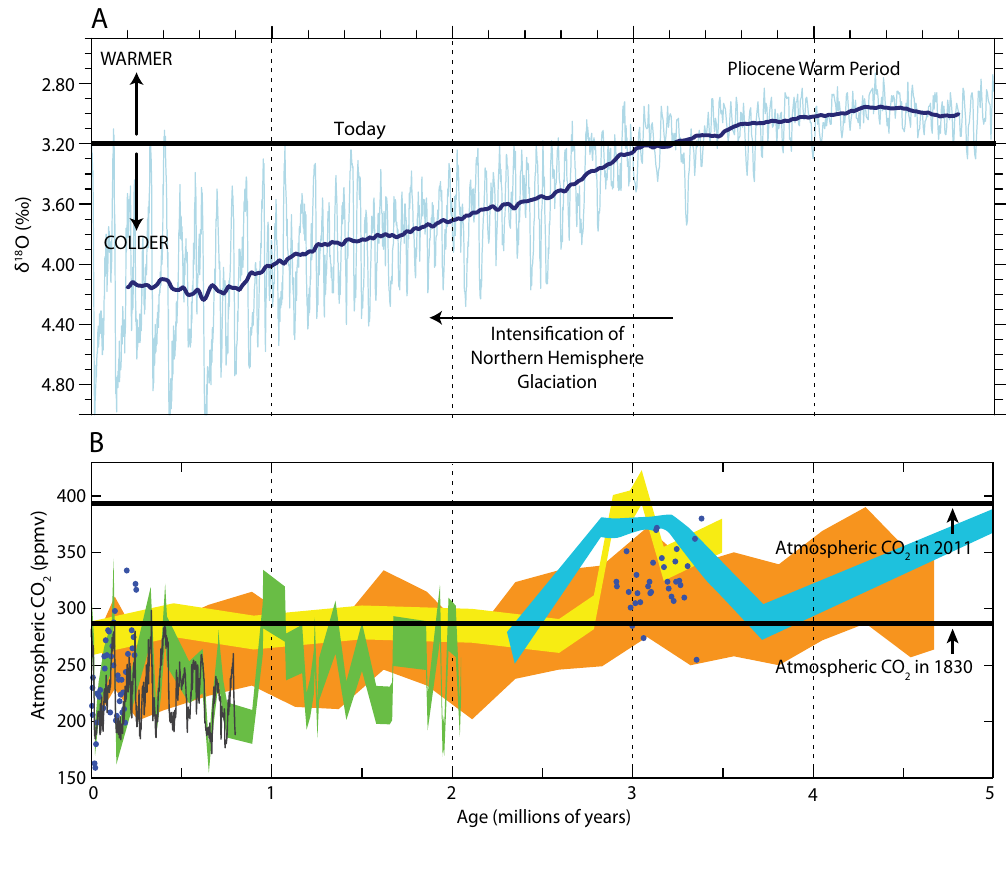
figure 2.1. (a) variations in benthic δ 18 o from 54 deep-ocean sediment cores showing dozens of cycles of global ice growth and decay (light blue), including the long-term average trend to gener- ally colder climates (dark blue), that have occurred over the last five million years (from lisiecki and raymo, 2005). The black horizon- tal line is the present-day reference level showing that climate prior to 3 million years ago was warmer on average whereas climate over the last 3 million years was almost always significantly colder than today. (B) estimates of past atmo- spheric co 2 concentrations derived from independent lines of evidence based on four different “proxy” methods (modified from a figure provided by a. fedorov).Black horizontal lines show atmospheric co 2 level in 1830 and